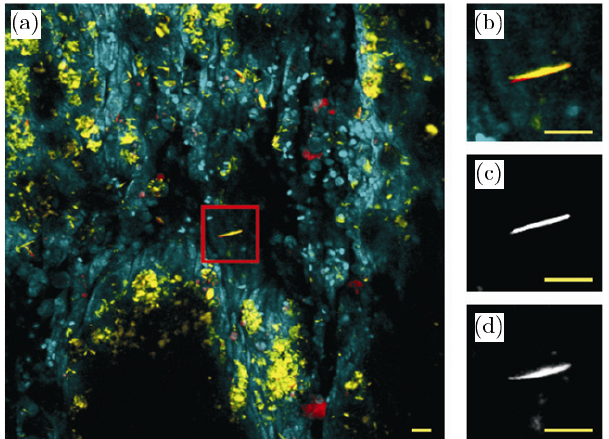
Fig. 4. CARS (red), TPF (cyan) and SHG (yellow) composed color image (a) recorded with en face optical geometry at a depth of about 40 (cid:1) m from tissue surface. The particular image within the red square is shown on a magni¯ed scale in (b). Cholesterol crystal within atherosclerotic plaque deposition (b). Image of the CARS signal (c) and SHG signal (d) of the image shown in B. Scale bars are 20 (cid:1) m. Image intensity and contrast of the three images composing Fig. (a) was properly adjusted before merging them in the overlaid image (a) in order to highlight the fact that the cholesterol crystal located in the inset is emitting both CARS and